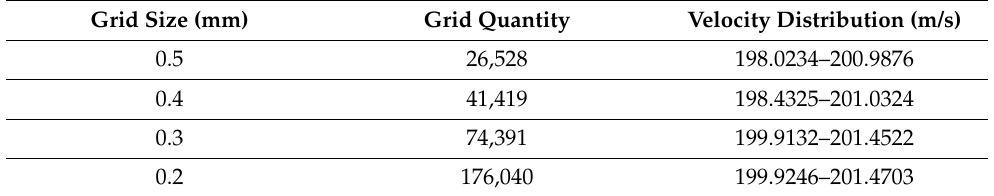
Table 2. Water jet velocity distribution of different grid sizes.